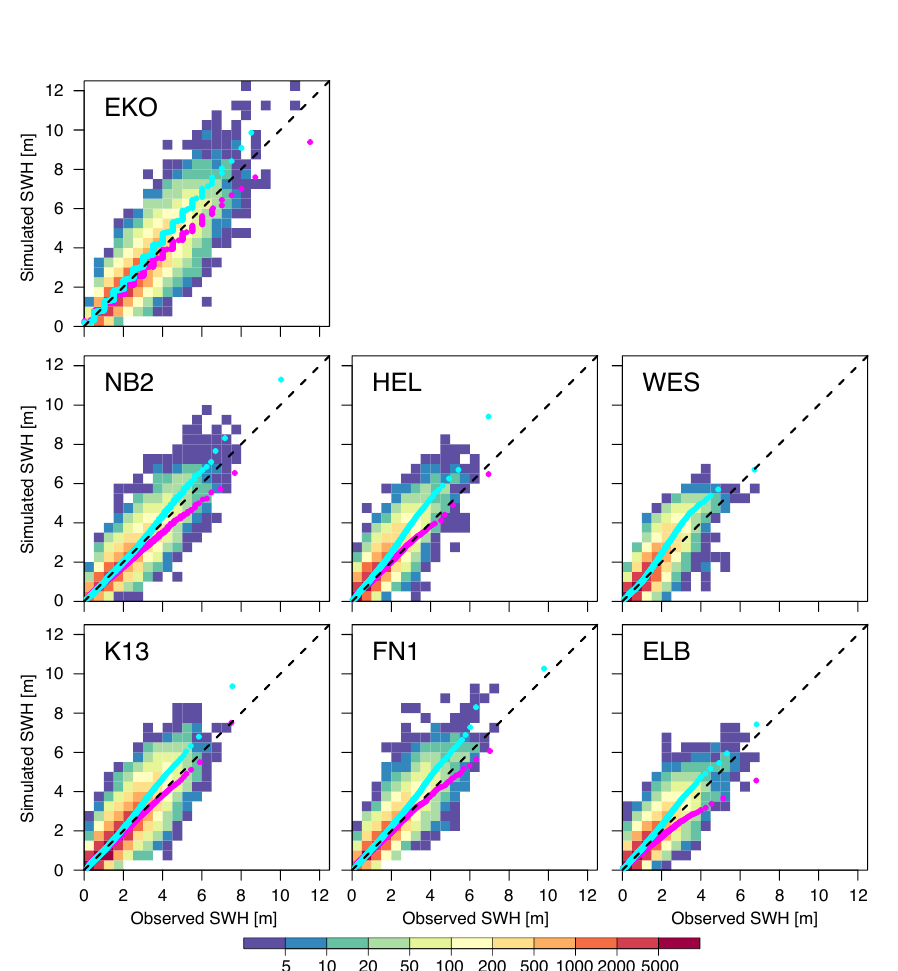
Figure 2. Scatter and quantile–quantile plot of SWH (in metres) between in situ observation ( x -axis) and coastDat2 hindcast data ( y -axis). Coloured squares indicate the number of data in each 0.5m × 0.5m bin. Coloured dots represent the percentile values of the quantile–quantile plots between observed and coastDat2 hindcast (cyan) and between observed and ERA-Interim reanalysis significant wave heights (magenta). Note that the comparison is made for different periods according to data availability (see Table